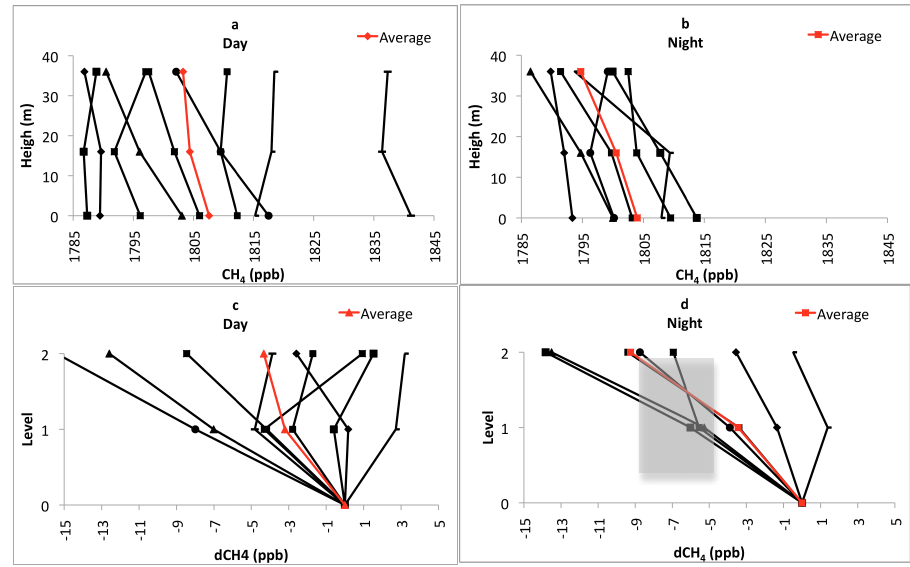
Fig. 5. Daytime and nighttime vertical gradient measurements. Panels (a) and (b) show CH 4 mixing ratios. Panels (c) and (d) show the relative difference ( d CH 4 ) between 36m (level 2) and 16m (level1) to the 2m (level 0). The grey-shaded area in (d) corresponds to the average CH 4 excess that is exchanged per hour from the canopy according to the calculations in Sect.